Question: Sum up the contents of this chart in one sentence.
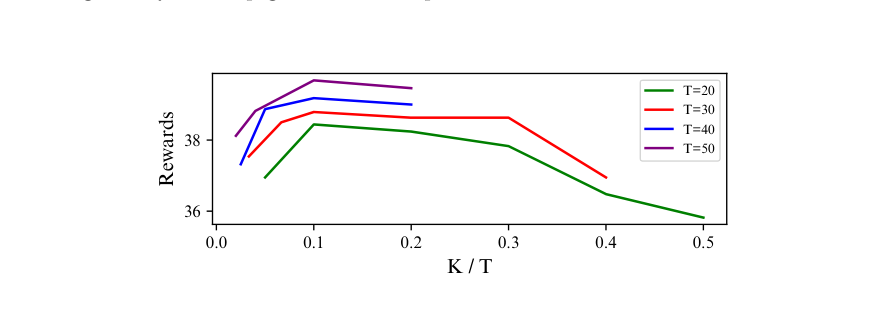
Answer: The impact of the number of training steps K vs. various total sampling steps T. Some data points are missing due to GPU memory constraint.